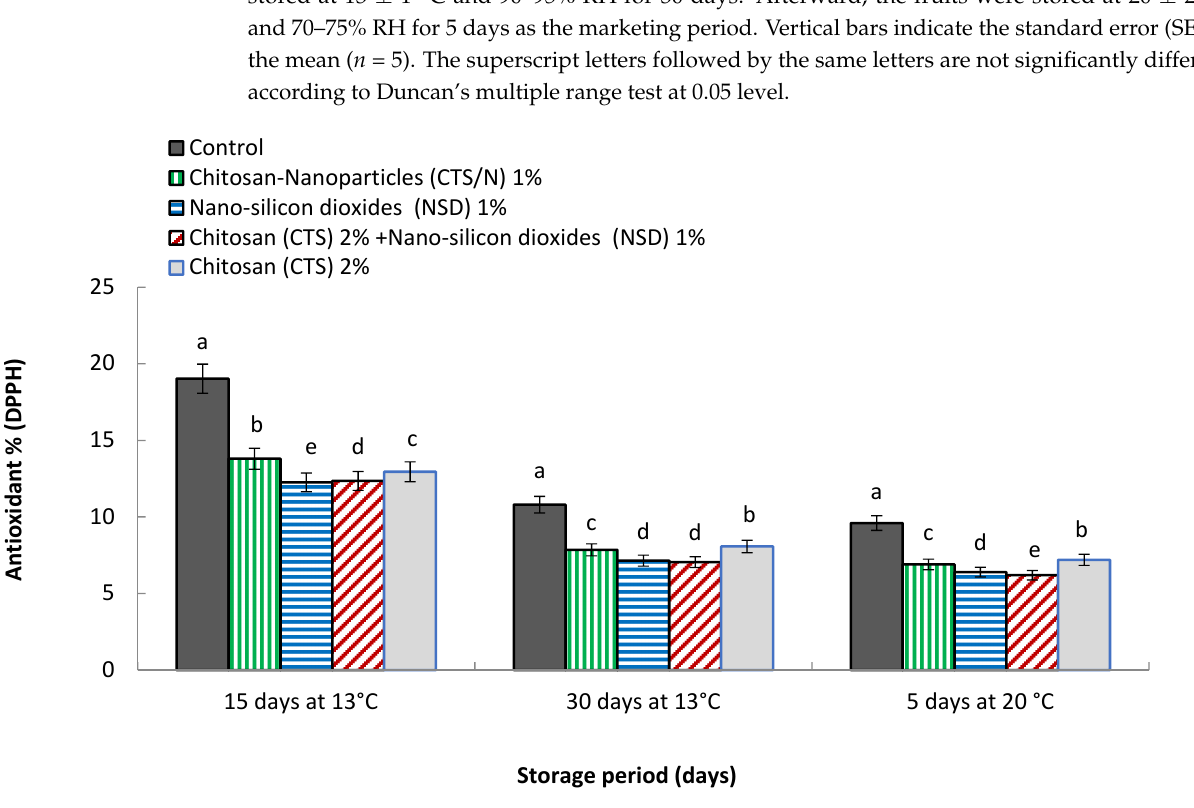
Figure 12. Antioxidant % (DPPH radical assay of fruit peel) as a mean of ‘Tommy Atkins’ mangoes from two seasons, stored at 13 ± 1 °C and 90–95% RH for 30 days. Afterward, the fruits were stored at 20 ± 2 °C and 70–75% RH for 5 days as the marketing period. Vertical bars indicate the standard error (SE) of the mean ( n = 5). The superscript letters followed by the same letters are not significantly different according to Duncan’s multiple range test at 0.05